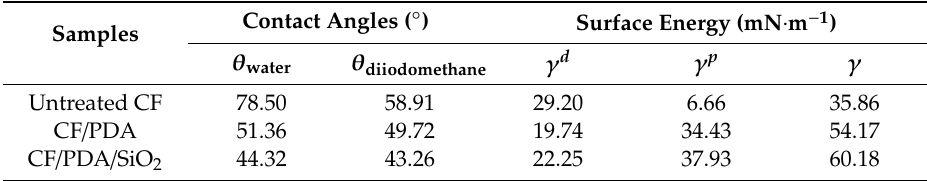
Table 1. Contact angles and surface energy of di ff erent CFs.